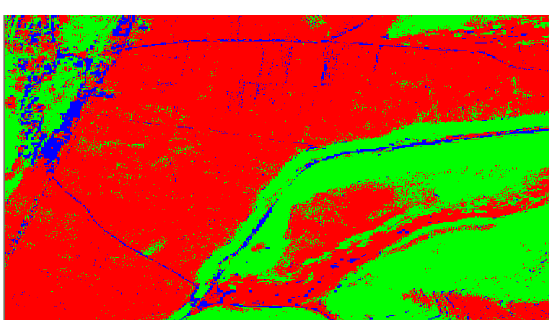
Fig. 6 The map of classification in study